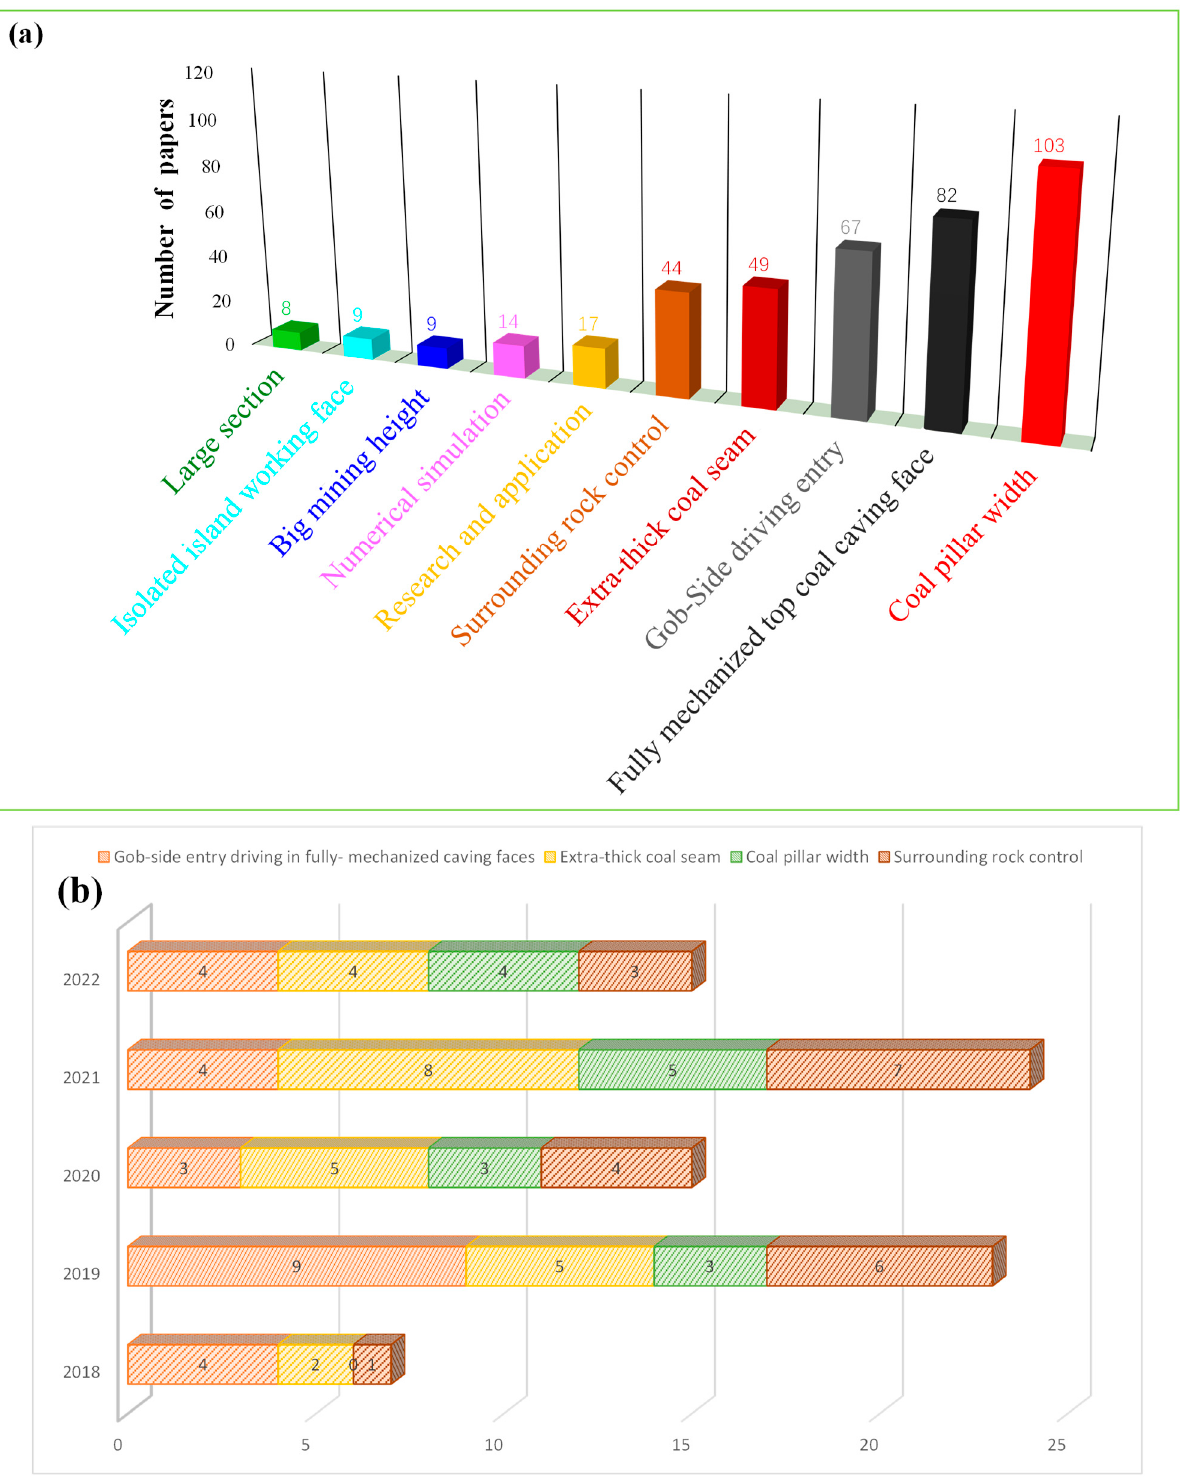
Figure 3. Research on gob-side entry driving technology in fully mechanized caving mining in China: ( a ) 10 research hotspots and ( b ) research trends in recent 5 years.